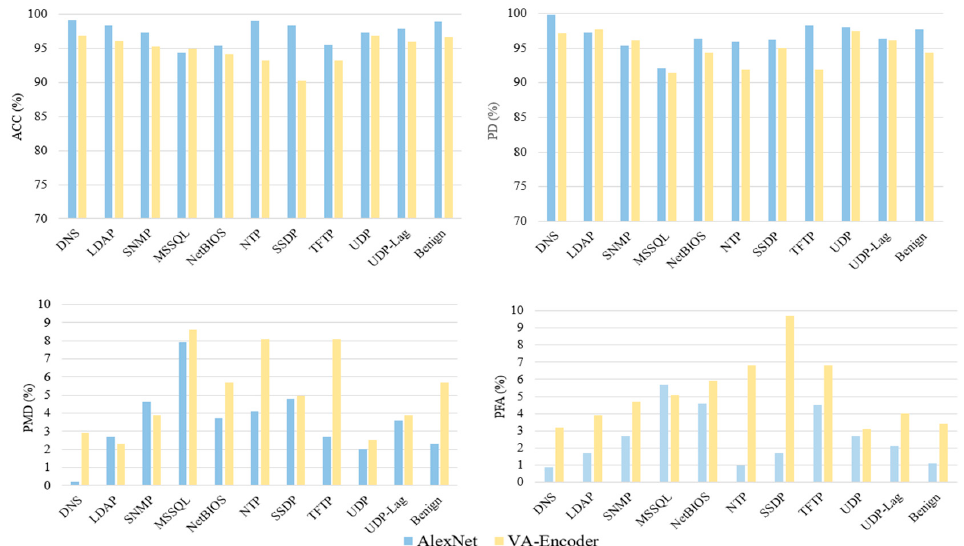
Figure 4. Performance evaluation of cyber-attacks based on best ML models in terms of ACC, PD, PMD, and PFA.